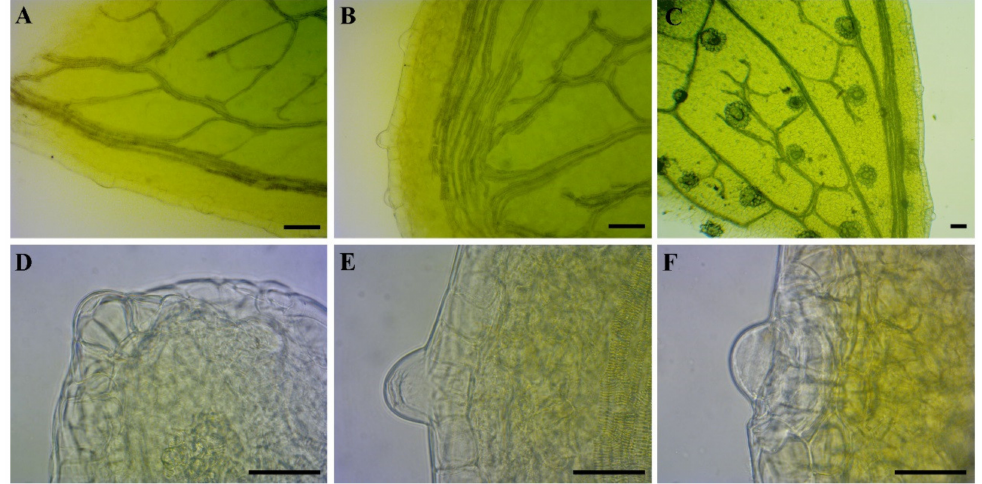
Figure 4. Leaves sampled of M. maritima plants from the jar ( A , D ), Plantform ( B , E ) and in vivo plants ( C , F ) after clarification with the Visikoll solution. ( A – C ) Leaf epidermis and veins and ( D – F ) waxy glands of the leaf margin. In ( A – E ), bars = 100 µ m; in ( F ), bar = 50 µ